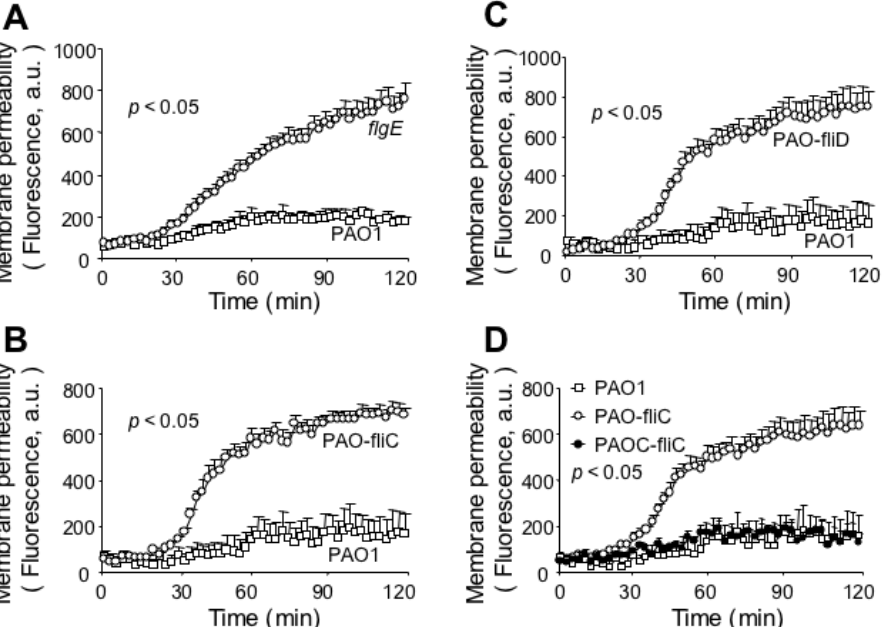
Figure 4. SP-A Preferentially Permeabilizes Flagellum-Deficient Mutants of P.aeruginosa. (A–C) SP-A preferentially permeabilizes flagellum- deficient flgE, fliC and fliD mutants. Bacterial cells from the wild-type PA01 and mutant strains flgE, fliC (PAO-fliC), and fliD (PAO-fliD) were exposed to 50 m g/ml human SP-A in the presence of the phosphatase substrate ELF97. Fluorescence was measured for 120 min using a fluorimeter and expressed as arbitrary units ( a.u. ). Data are the mean 6 SE, n =6–8. The difference in membrane permeabilization between flgE mutant and PA01 was significant from 31 st -min onward. * p , 0.05. The differences in membrane permeabilization between PAO-fliC and PA01, and between PAO-fliD and PA01 were both significant from 32 nd -min onward, respectively. * p , 0.05. (D) Genetic complementation of flagellar function restores resistance to SP- A-mediated membrane permeabilization. PAOC-fliC (open square), a fliC mutant harboring a copy of wild-type fliC gene is as resistant to SP-A- mediated membrane permeabilization as the parental strain PA01 (open circle). Data are the mean 6 SE, n =6. The differences in membrane permeabilization between fliC and PA01, and between fliC and PAOC-fliC, were significant from 32 nd -min, and 34 th -min onward, respectively. * p ,